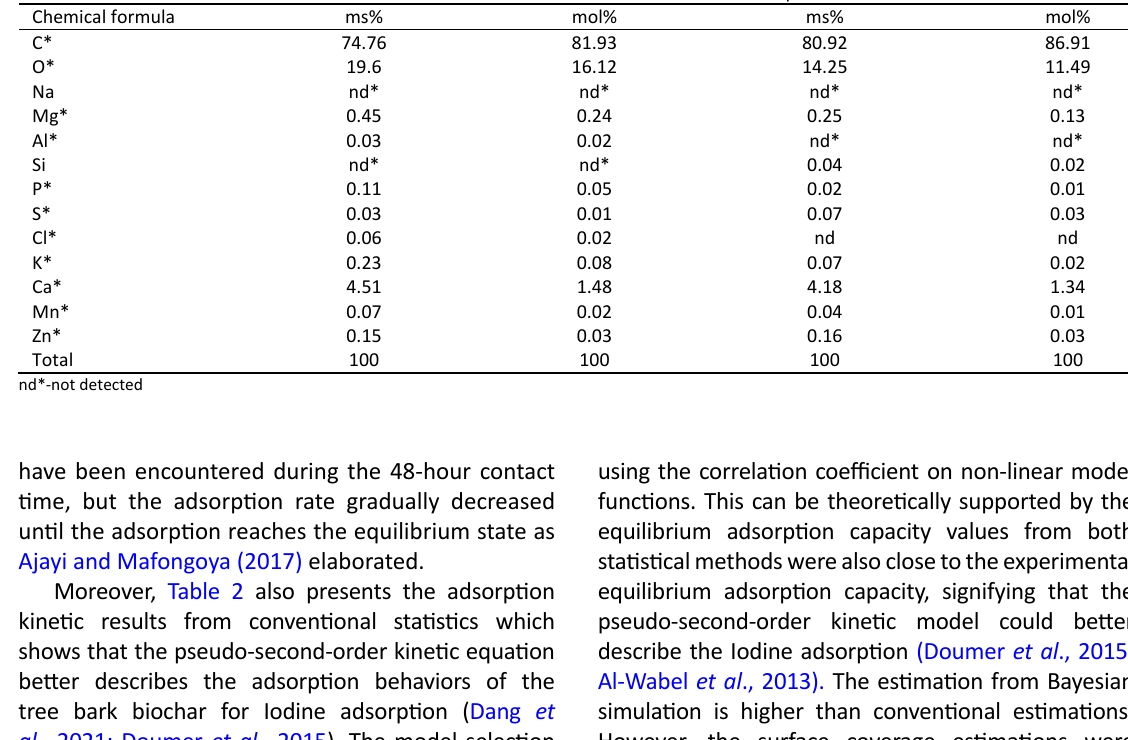
Table 1: The chemical composition extracted from the EDX analysis for Mupane and Mushuma barks biochar modified at 600 ˚C for 2 hrs. i n mass and moles units.